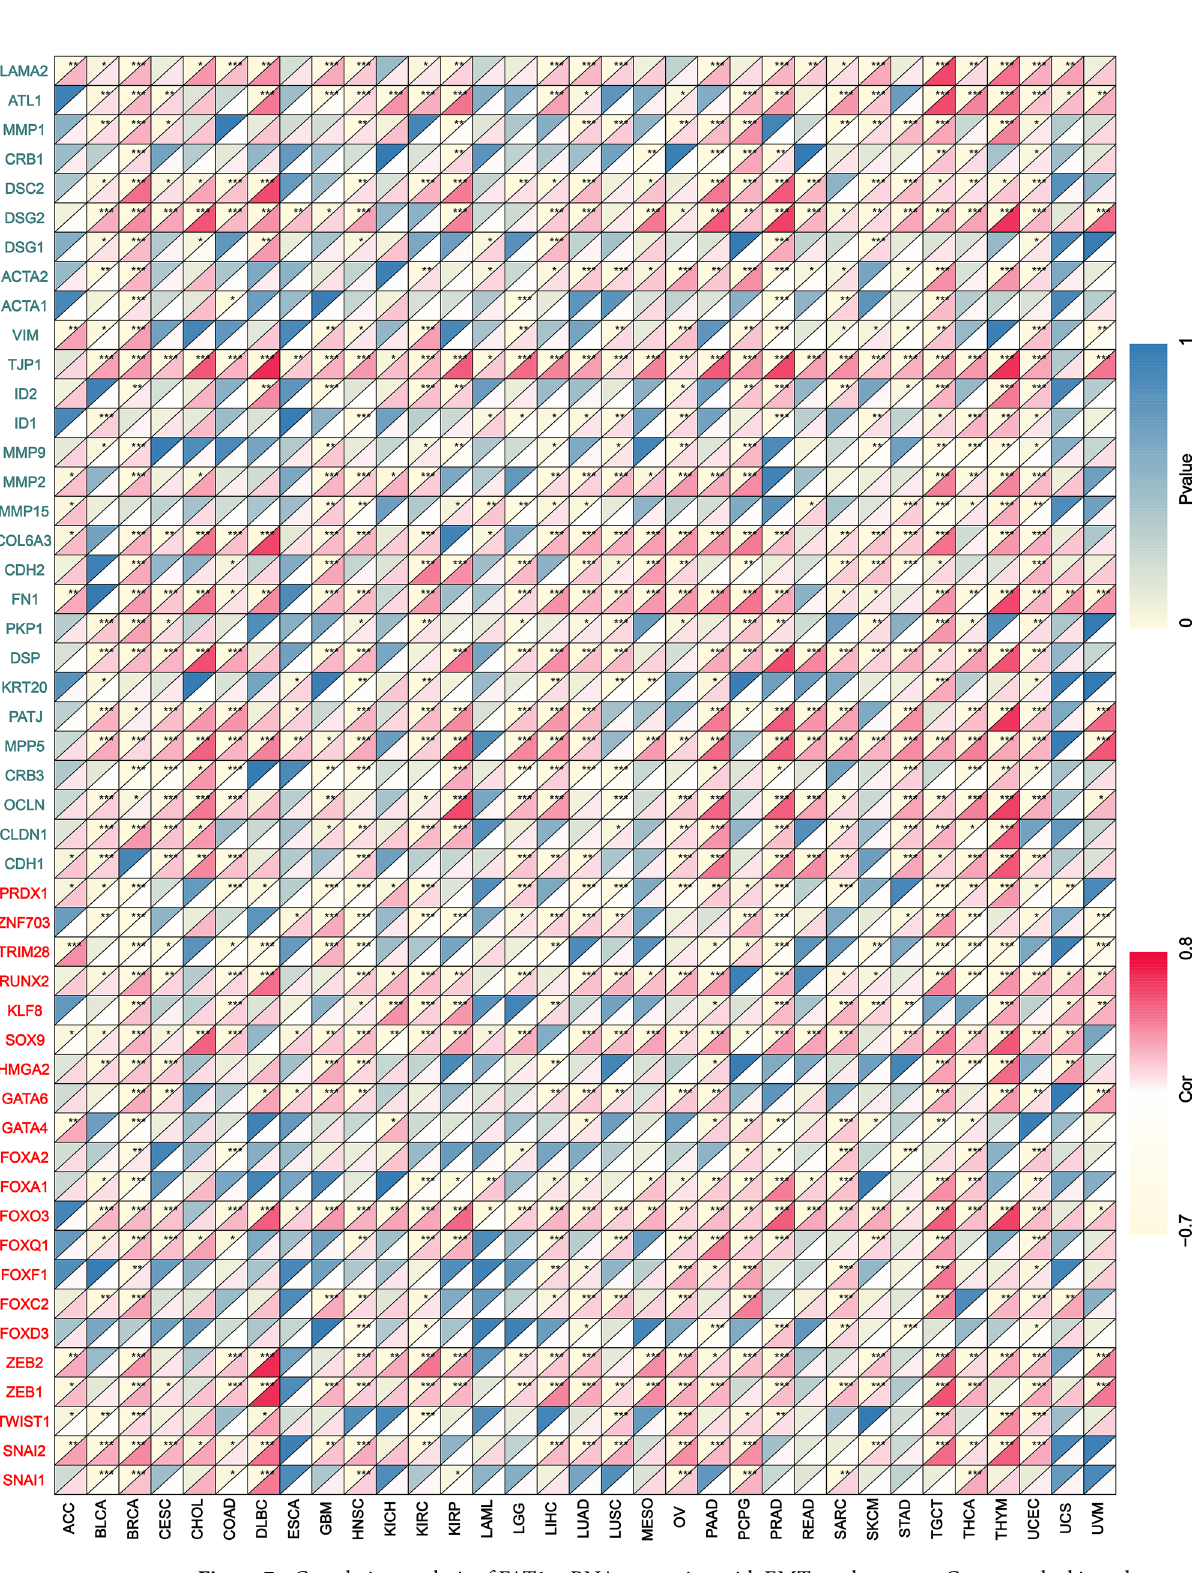
Figure 7. Correlation analysis of FAT1 mRNA expression with EMT marker genes. Genes marked in red are EMT transcription factors, and green genes indicate EMT transcription factor